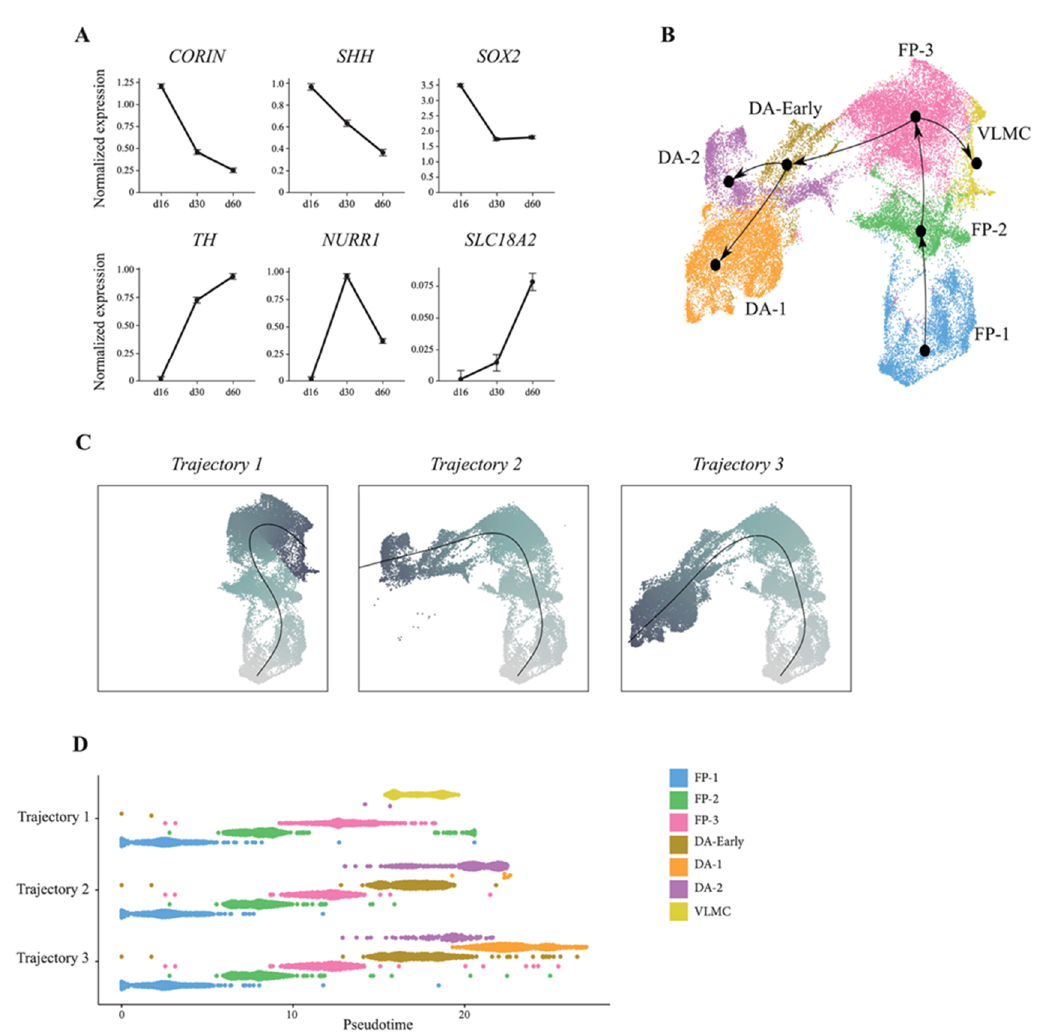
Figure 4. ScRNAseq reconstructs developmental trajectories during VM-patterned hPSC differentiation. ( A ) Temporal expression pattern of early and late DA markers during hPSC VM differentiation (16–60 days). ( B ) Slingshot-based pseudotime trajectories calculated from UMAP embeddings showing combined developmental trajectories of all identified cell types and, ( C ) individual trajectory curves colored by pseudotime. ( D ), Pseudotime inference reconstruction plot showing the appearance and temporal progression of cell-types along a pseudotemporal axis.